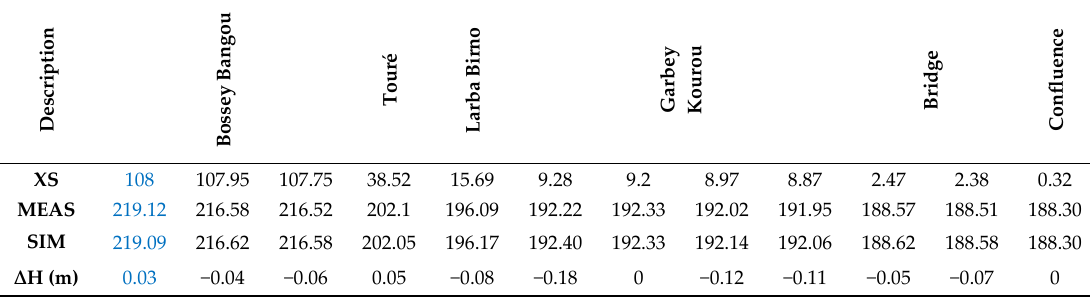
Table 4. WSE (in meter above sea level) of the water level measured (MEAS) in September 2018, simulated (SIM) and difference, in meter, between measured and modeled discharge (∆H) for the detected river cross-section (XS). The blue values are referred to a marker for the 2012 flood level.